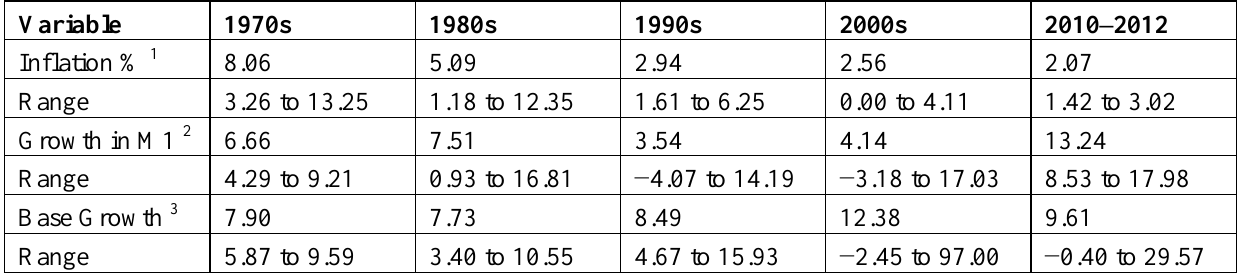
Table 10. Inflation Rates, Growth Rates of M1, and Growth rates of the Monetary Base in Percentages by